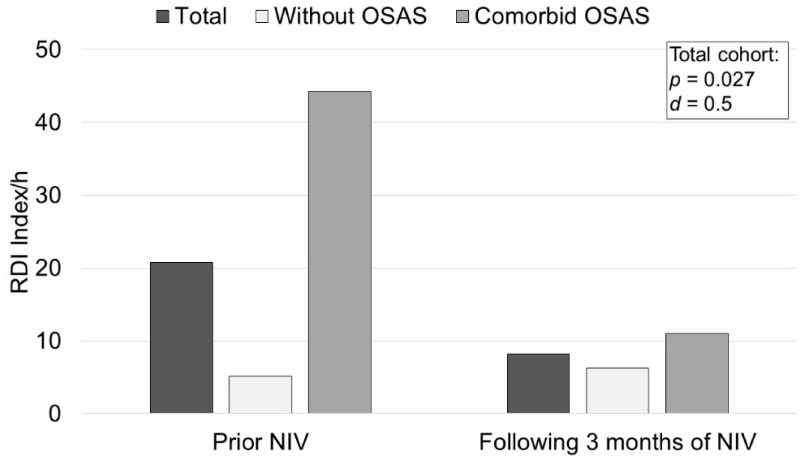
Figure 6. Results of the Respiratory Disturbance Index (RDI). Notes: RDI was used to classify the severity of respiratory events (mild 5–14.9, moderate 15–29.9, and severe >30). The p -value for the 2- tailed t -test and Cohan’s d for effect size are only reported for the entire cohort ( n = 25). Abbreviations: RDI: index of abnormal breathing events per hour; OSAS: obstructive sleep apnea syndrome; NIV: non-invasive ventilation; d : Cohan’s d